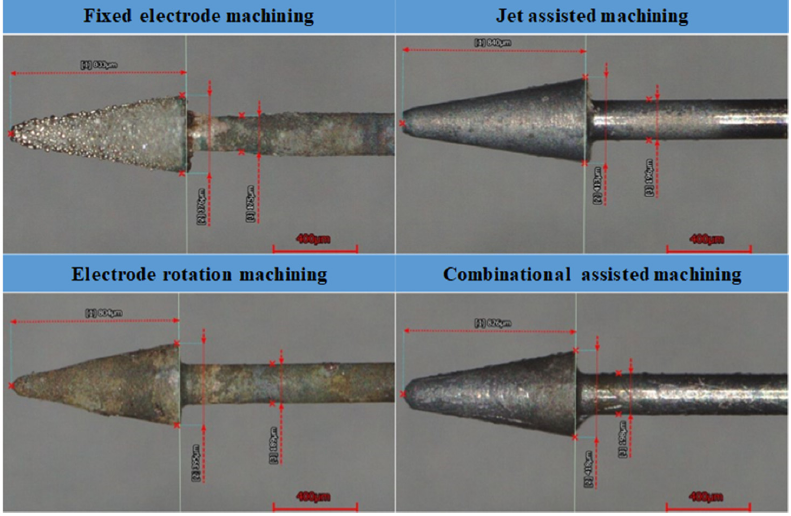
Figure 6. Electrode wear conditions of the different machining methods.